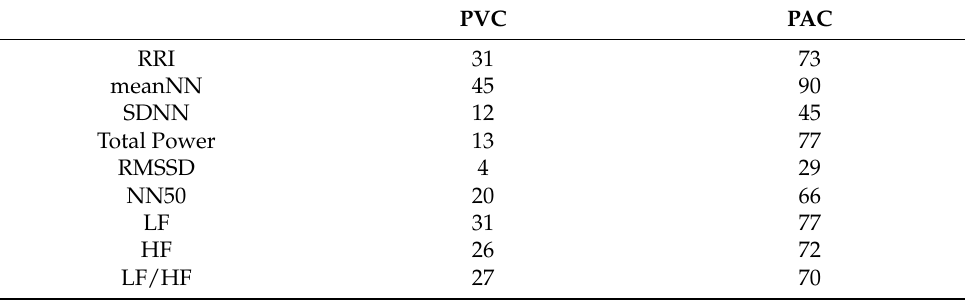
Figure 8. The HRV features extracted from the RRI data with and without PVC modification. The blue, red, and green lines represent the original HRV data, the HRV data extracted from the RRI with artificial PVC data, and the HRV data extracted from the RRI data modified by the proposed DAEM, respectively. The modified data (the blue line) overlapped almost entirely with the original data (the green line). Table 1. The average decrement rates [%] of RMSE by